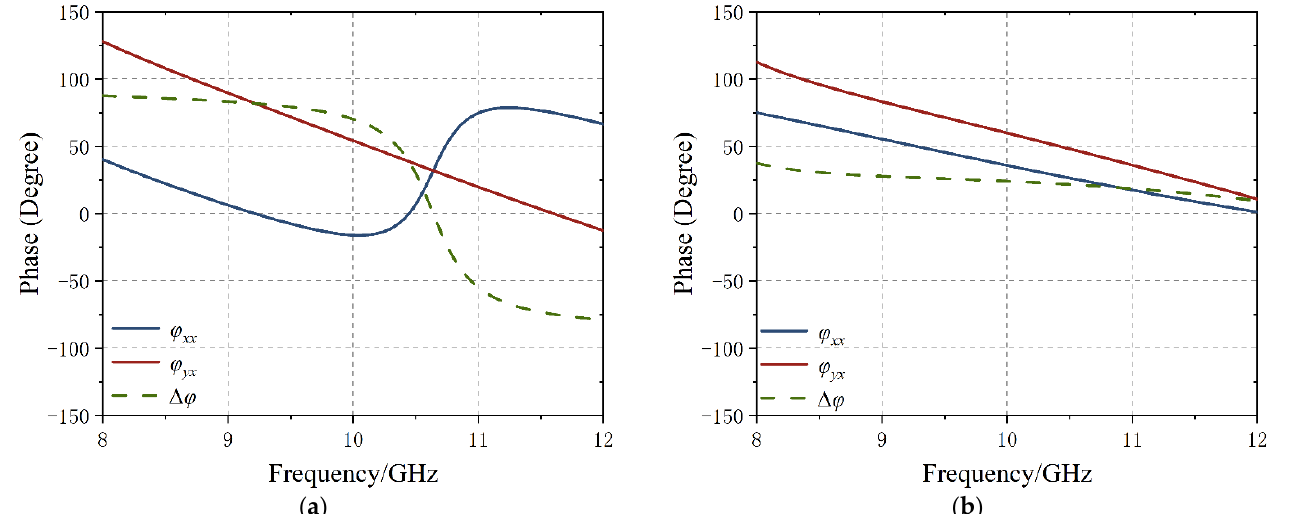
Figure 4. The simulated reflective phase and difference. ( a ) Diodes off; ( b ) Diodes on.